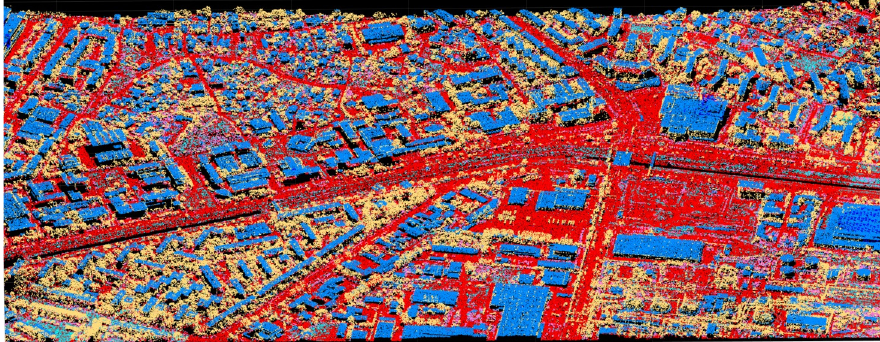
Figure 12. Classified HR ALS point cloud for the study area with a density of 3.1 points/sqm.